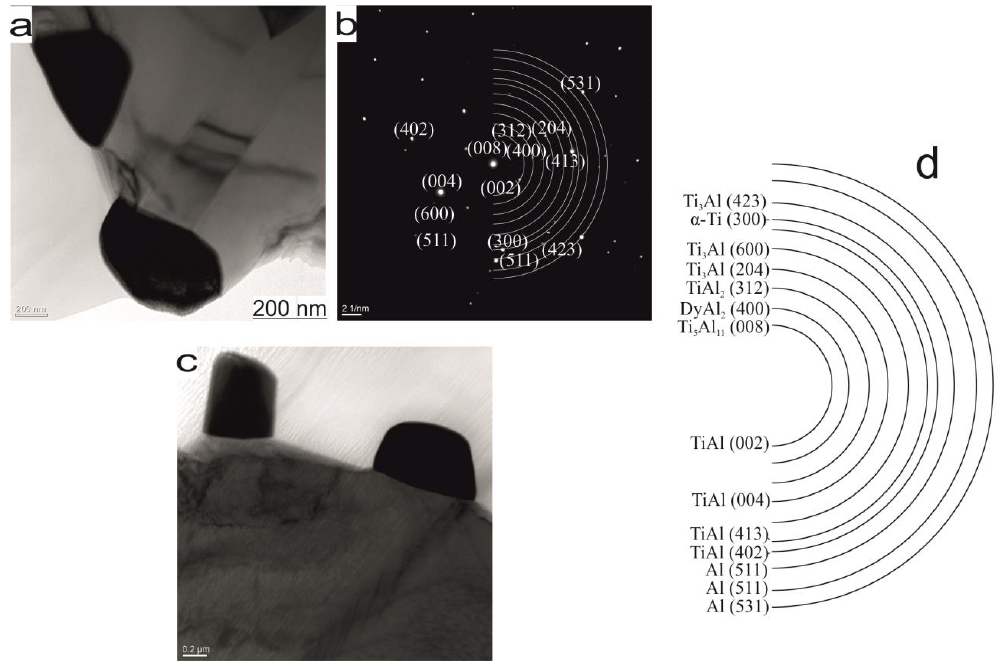
Figure 8. Electron microscope images of the TAD alloy: ( а) bright-field image; ( b) microdiffraction pattern; ( c) dark-field images in the reflex; ( d) microdiffraction pattern identification. pattern; ( c ) dark-field images in the reflex; ( d ) microdi ff raction pattern identification.